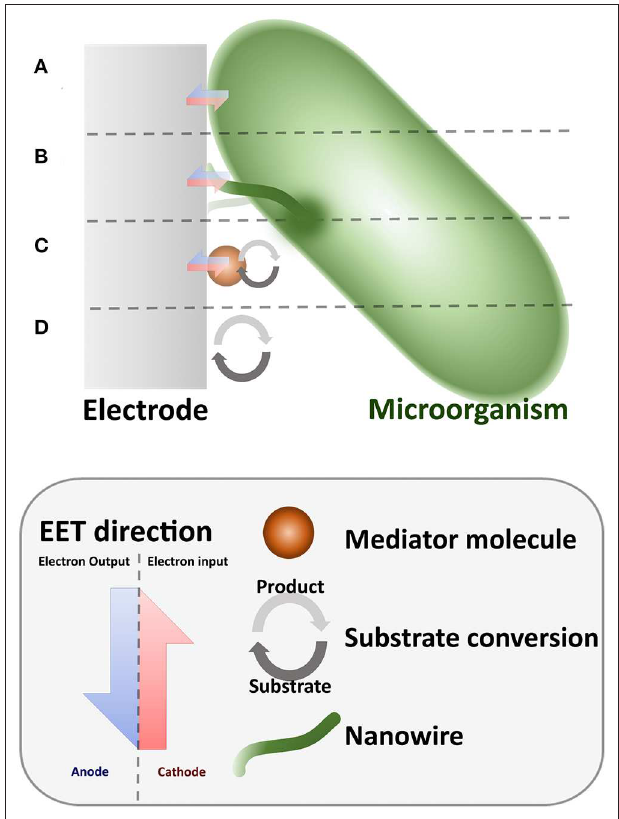
FIGURE 1 | Schematic representation of the different mechanisms of EET in MES. (A) Direct EET. (B) Nanowire (Direct) EET. (C) Mediated EET. (D) No